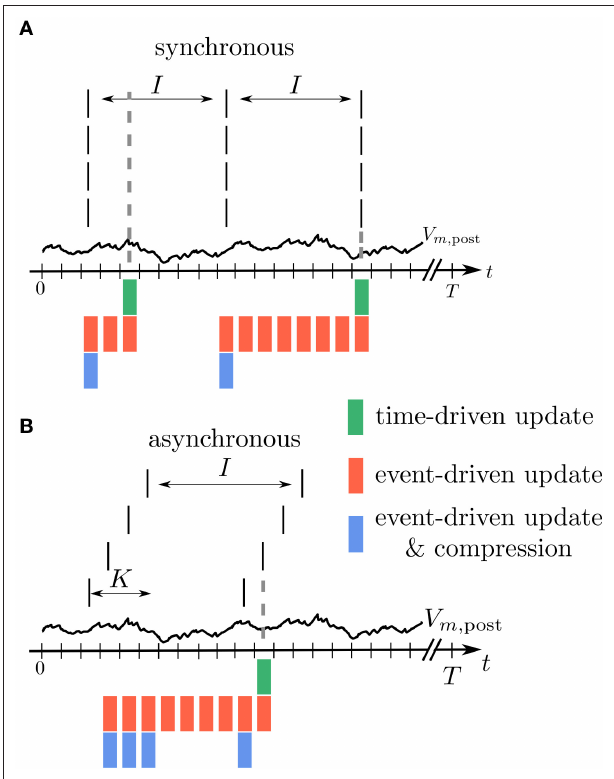
FIGURE 5 | Illustration of buffer sizes for different simulation schemes in case of fully synchronous or asynchronous spikes. (A) All incoming spikes arrive synchronously: In the time-driven scheme the synaptic weight is updated in every time step of the simulation, so that only the current value of V m ,post needs to be available (green). In the event-driven scheme every synapse processes V m ,post from the last spike to the current one. Therefore, the relevant time trace needs to be stored (red). In the compressed event-driven scheme this part of V m ,post is processed only once and used to update the weight of all the synapses. Since the weight change is a function of the last spike time which is the same for all the synapses, only one value needs to be updated (blue). In this situation the length L of the compressed history is i = 1, see Table 1 . (B) All incoming spikes arrive in different time bins: For the time-driven and the event-driven scheme the scenario is similar to (A) . For the compressed event-driven scheme the number of values that need to be updated equals the number of incoming synapses K so that i = K .